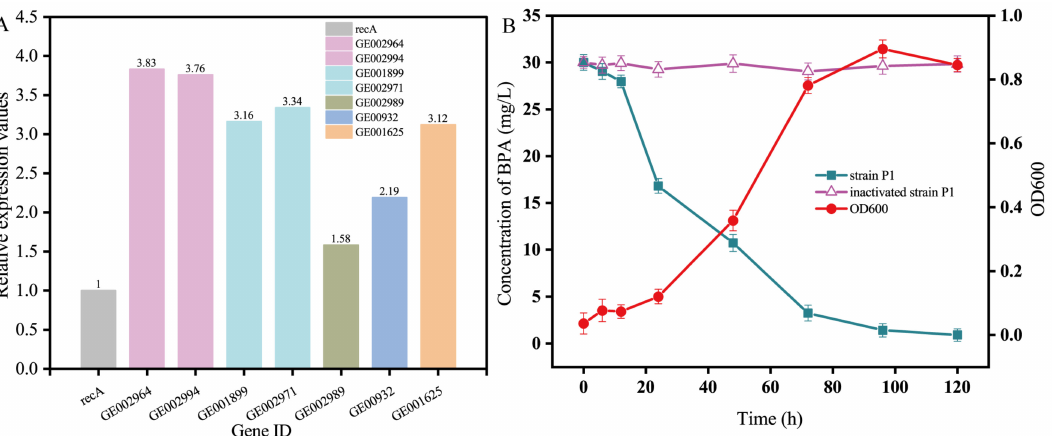
Figure 3. ( A ) Expression levels of genes encoding BPA-degrading enzymes: (GE002964, GE002994) Cytochrome P450; (GE001899, GE002971) Ferredoxin; (GE002989) Hydrolase; (GE000932) Copper oxidase; (GE001625) Laccase; ( B ) degradation capacity of strain P1 under optimal conditions; OD600 value of the bacterial